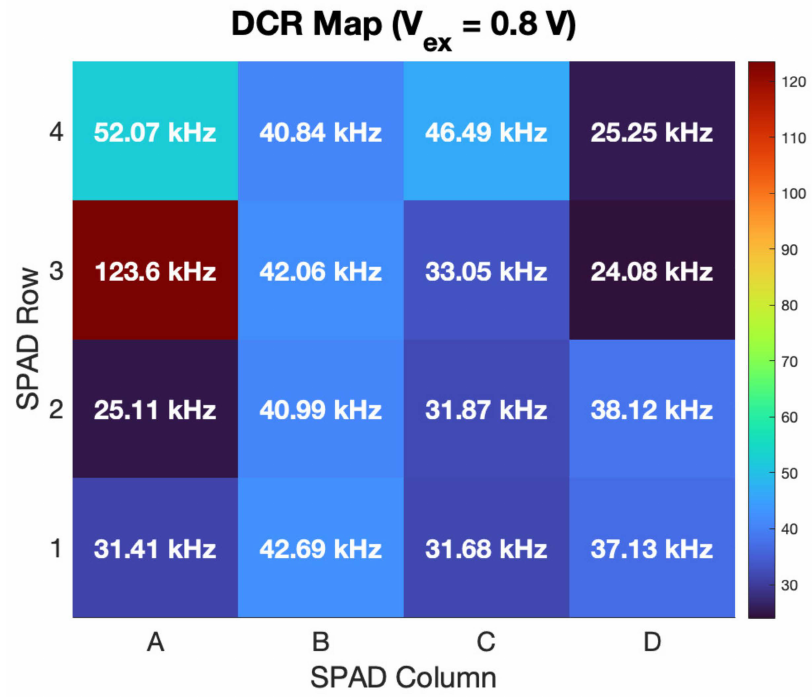
Figure 11. Dark count rate (DCR) map of the SPAD array with a 0.8 V excess